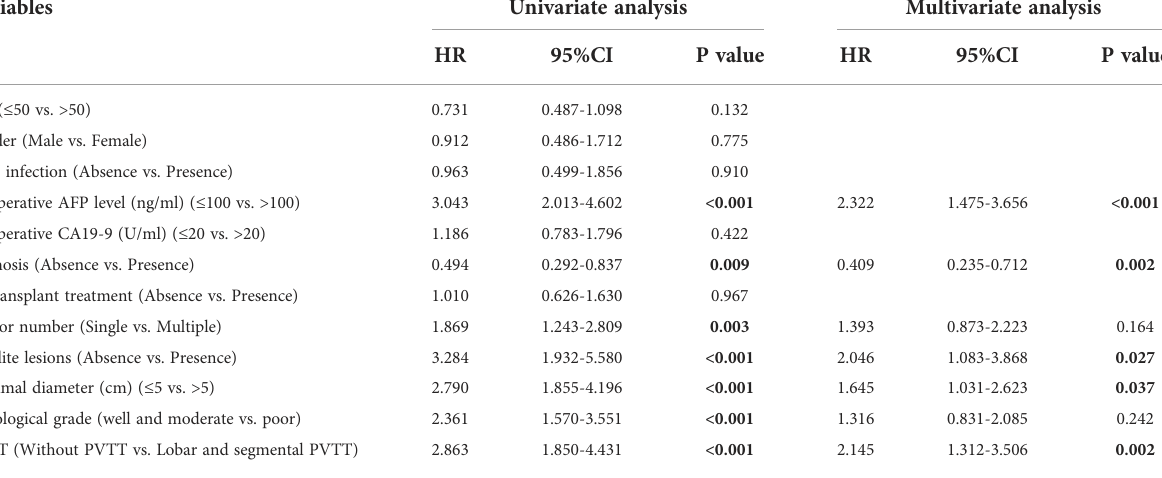
TABLE 6 Univariate and multivariate analysis of prognosis factors for overall survival in patients who underwent deceased LT.